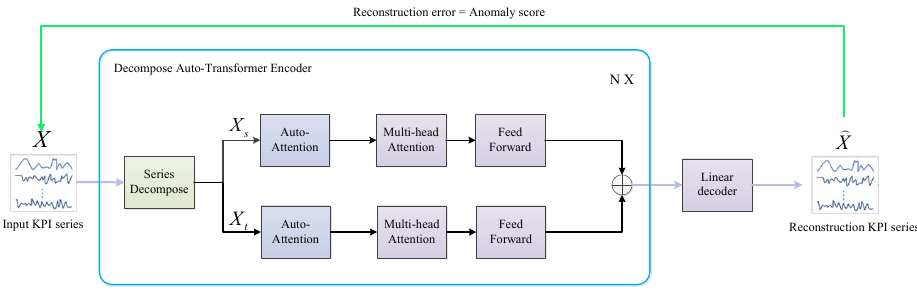
Figure 1. Decompose Auto-Transformer network (DATN),